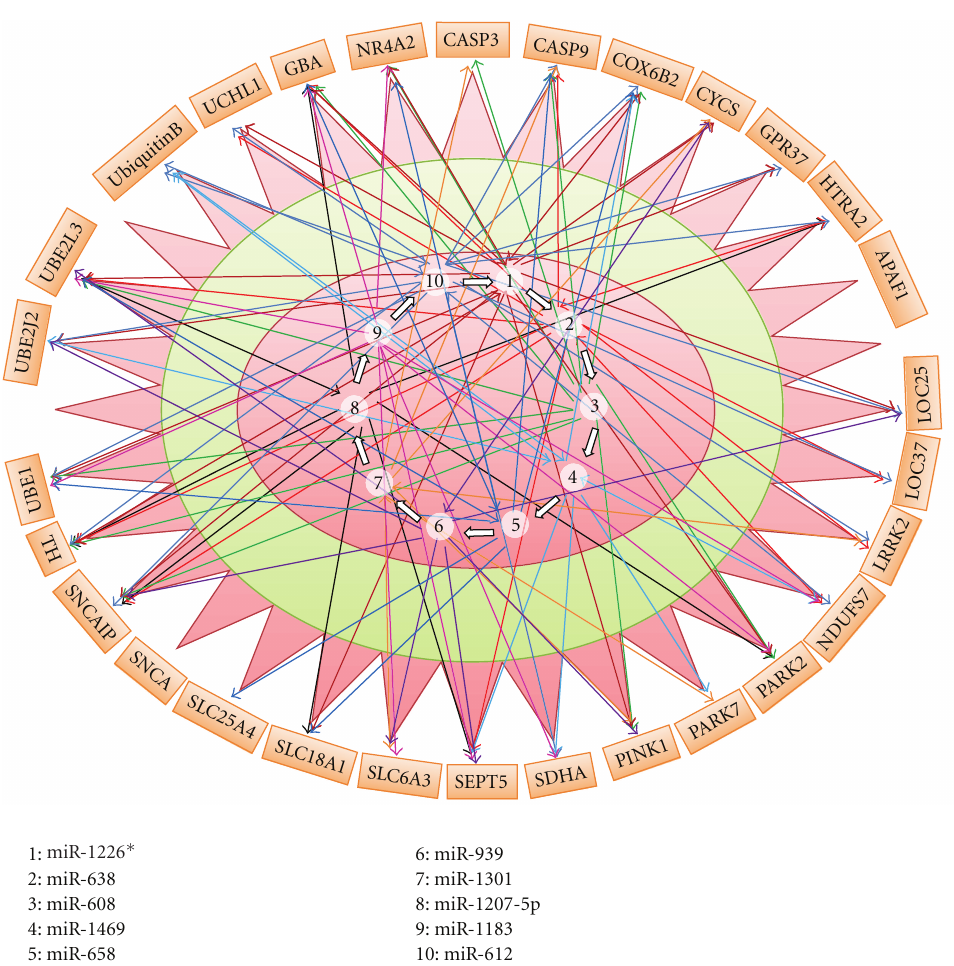
Figure 5: Interaction map of miRNA and selected 29 genes. Interactions among genes and miRNAs are depicted with